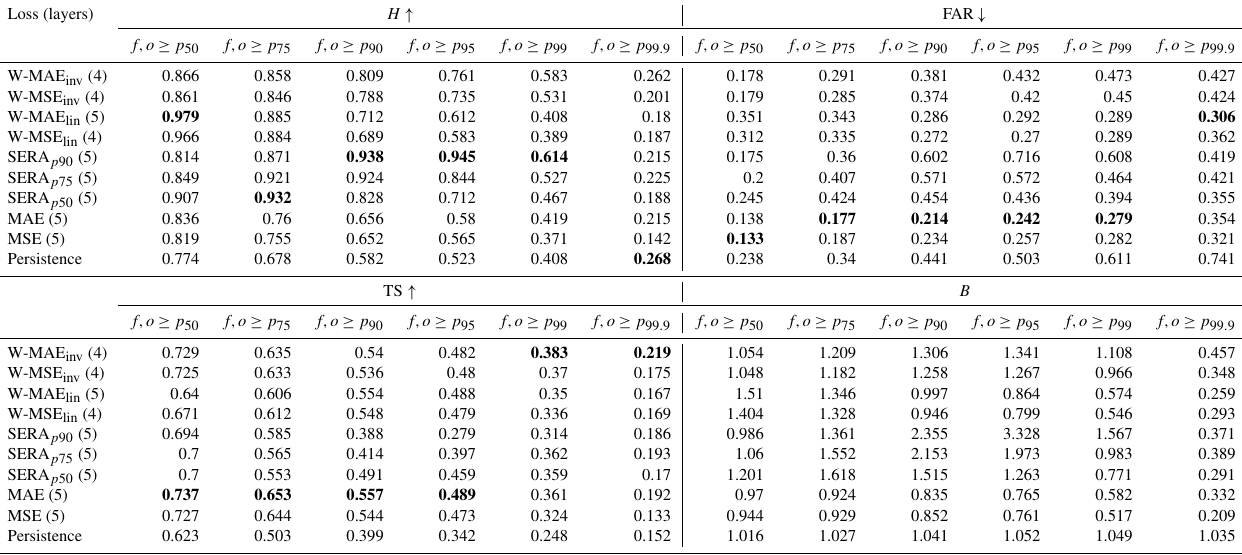
Table 3. Comparison of hit score ( H ), false alarm ratio (FAR), threat score (TS) and frequency bias ( B ) of the ConvLSTM network trained with each different loss function. Scores are presented for wind forecasts f and observations o exceeding local intensity thresholds varying between the 50th ( p 50 ) and 99.9th ( p 99 . 9 ) percentiles, aggregated over lead time. The optimal number of network layers used for each loss function is given in brackets after the name of the loss function. The persistence forecast is included in the table for reference. For each intensity threshold, the best scores are emphasised in boldface (where